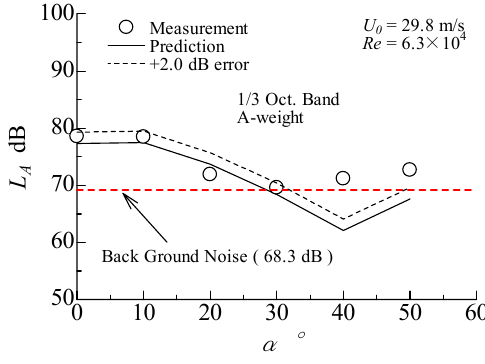
Fig.14 Relation between the angle of attack and the aerodynamic noise